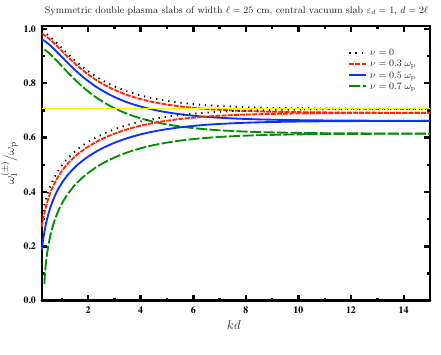
Figure 4: Dispersion curves of two identical plasma slabs with vacuum as a central